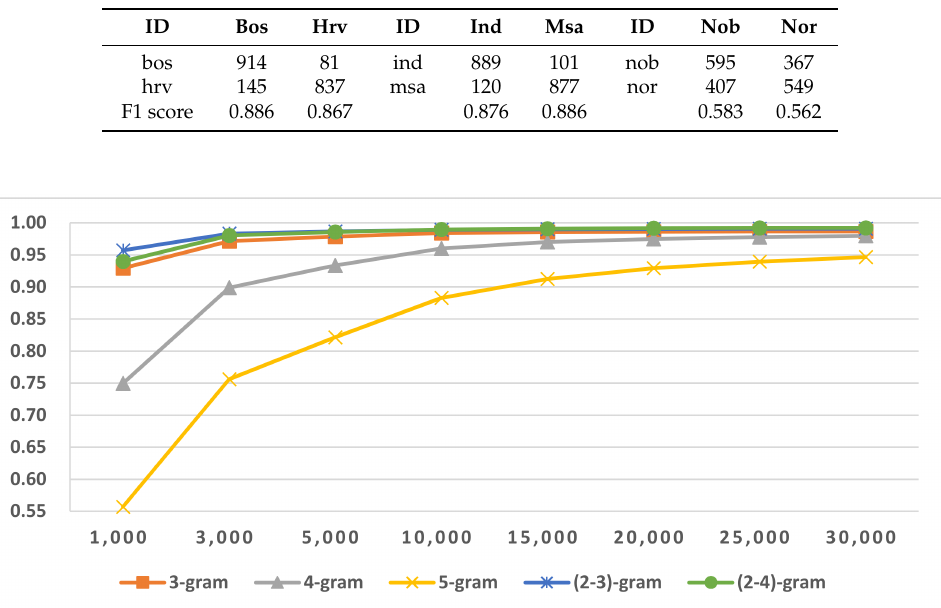
Table 17. Confusion matrix and F1-score related to similar languages in three-stage LI-1.